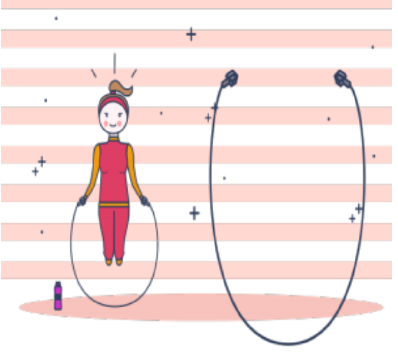
Figure 3. Interface of the game “Jump the